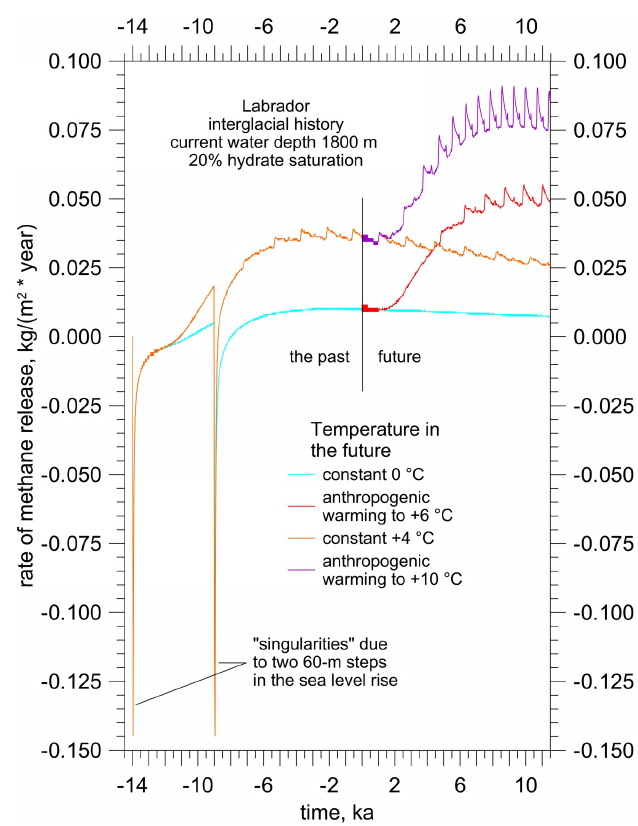
Figure 14. Model methane release rate (kg m − 2 yr − 1 ) history for the Labrador Sea for a current 1800 m water